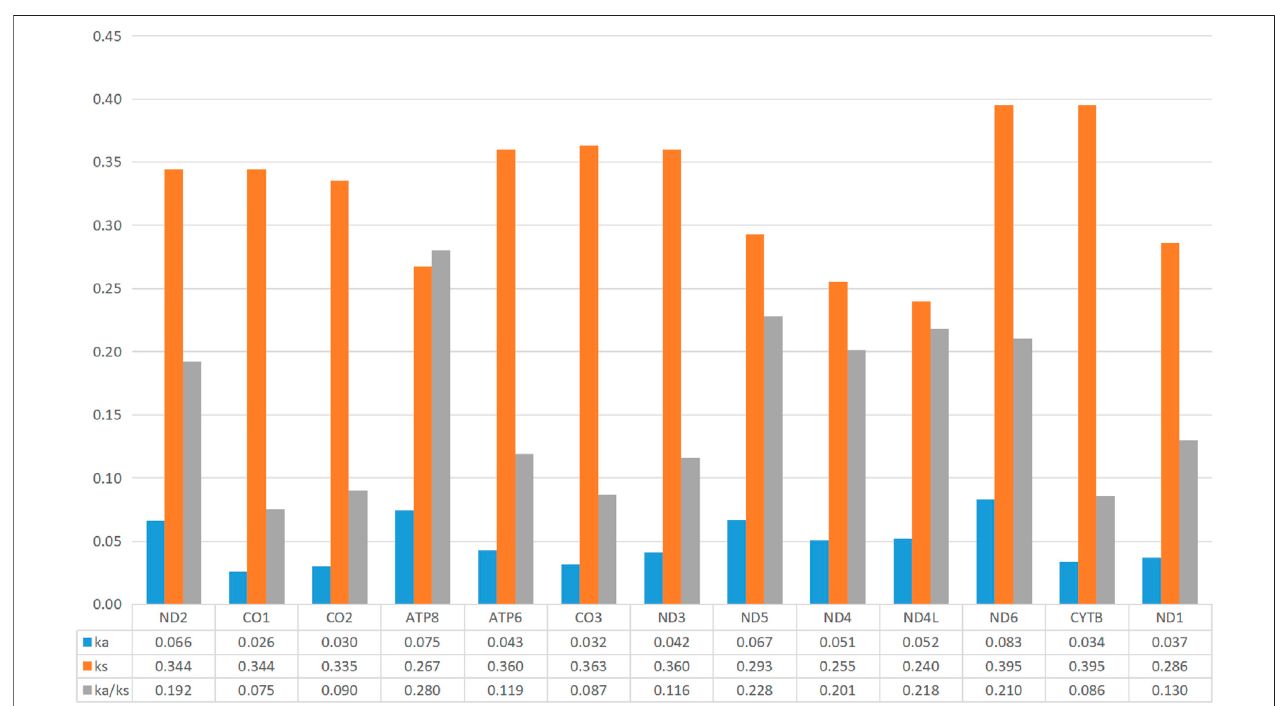
FIGURE 4 | Evolutionary ratio of 13 PCGs, 2 rRNAs, and 22 tRNAs in the mitogenome of 35 calliphorid species. Synonymous nucleotide substitutions per synonymous site (Ks), non-synonymous nucleotide substitutions per non-synonymous site (Ka), and the ratio of Ka/Ks were calculated.